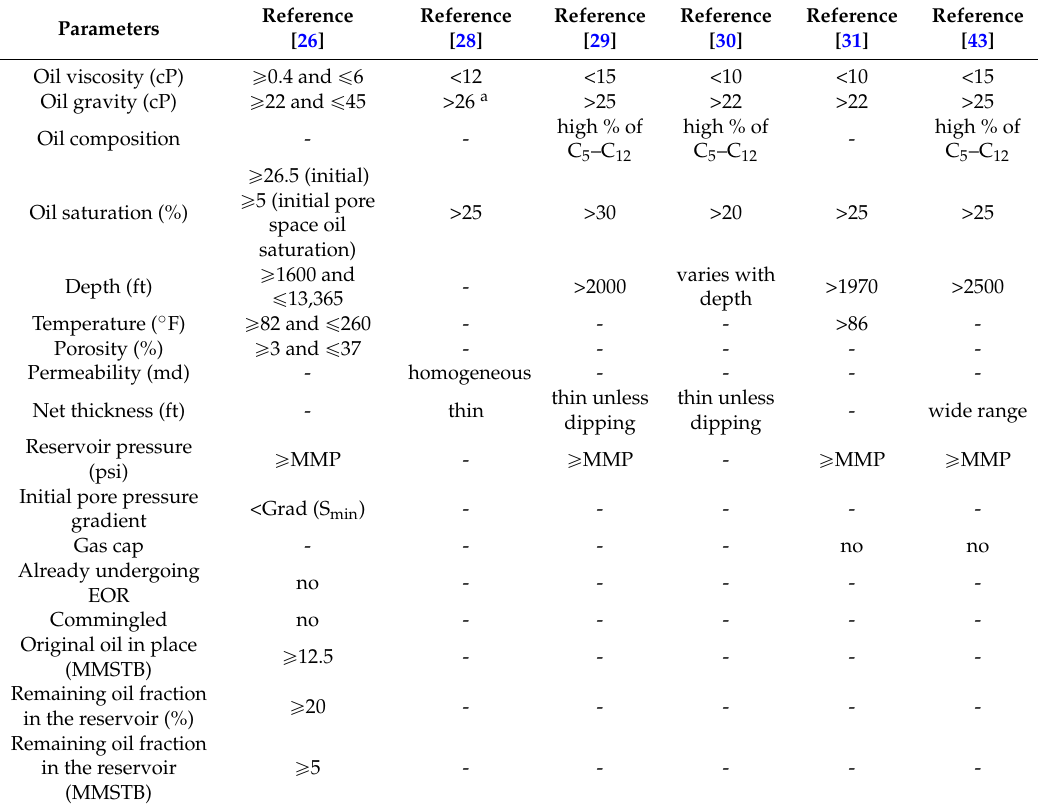
Table 4. Previously-suggested screening criteria for the CO 2 miscible process. Table 4. Previously ‐ suggested screening criteria for the CO 2 miscible process.